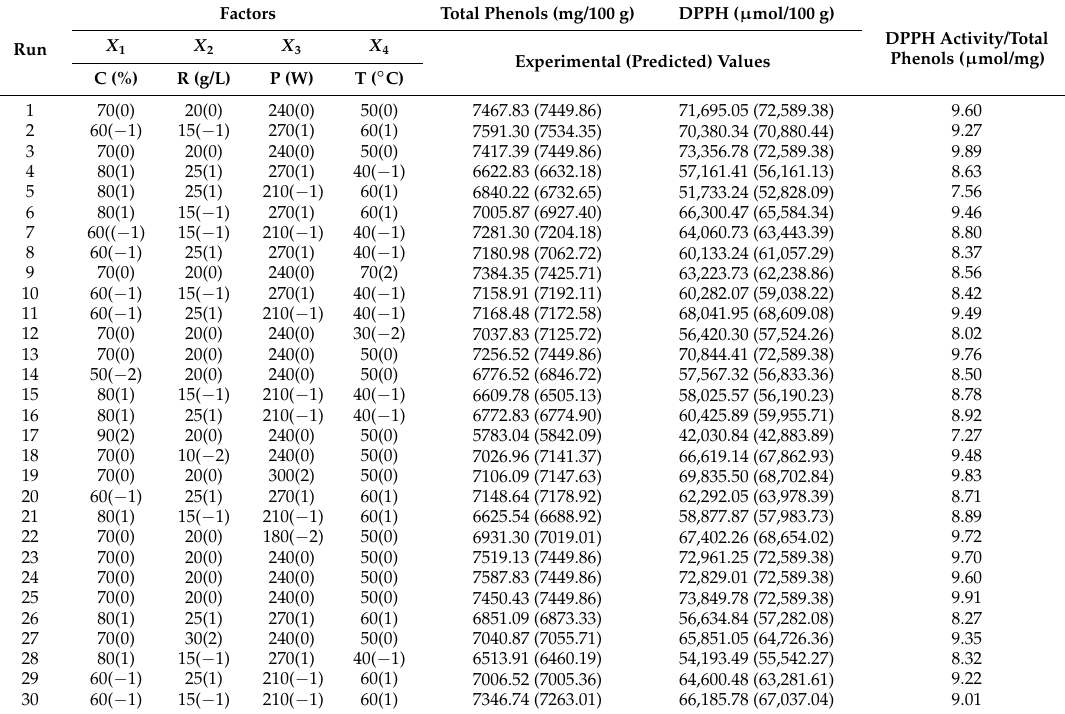
Table 1. Response surface central composite design and experimental data and predicted values for extraction yield of phenols in